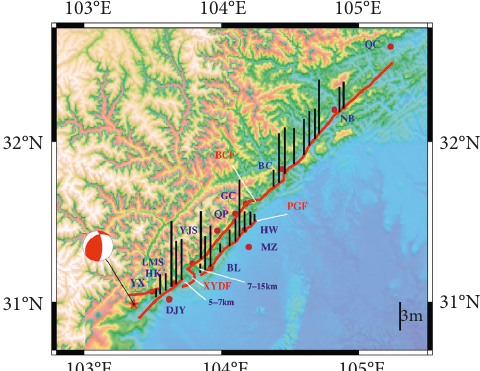
Figure 1: Epicenter of the Wenchuan earthquake (red stars): surface rupture along the Longmenshan fault zone (red lines). The black lines are the surface offsets according to Xu et al. [1, 3, 4] to limit the slip of near-surface faults. Here, YX, Yingxiu; HK, Hongkou; DJY, Doujiangyan; LMS, Longmenshan; YJS, Yuejia-